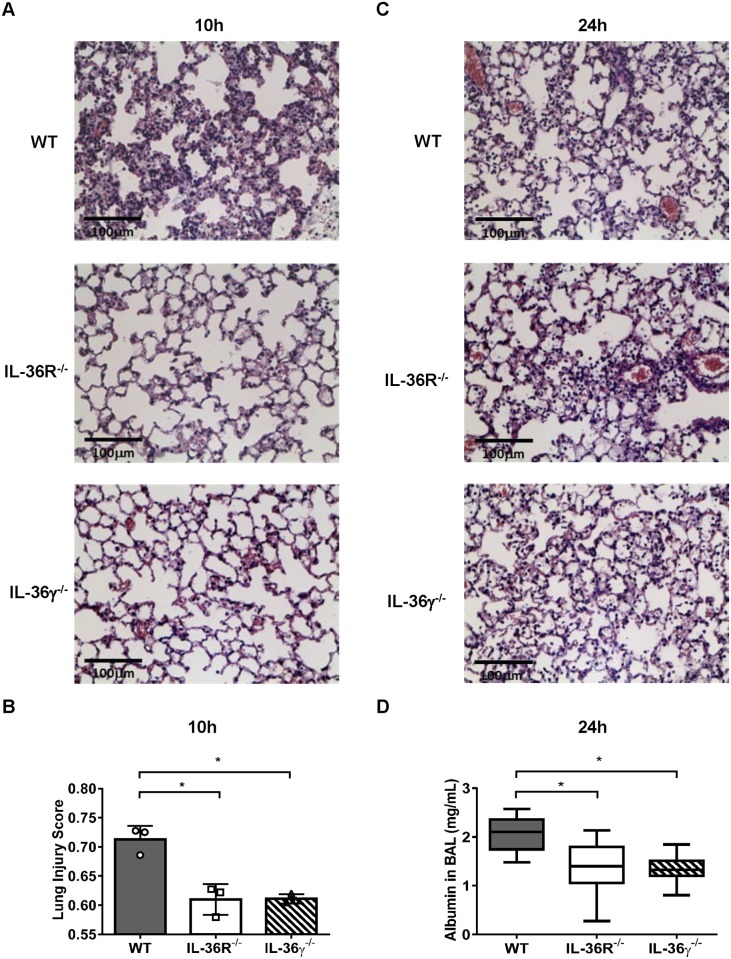
IL-36 receptor and IL-36γ deficient mice attenuated lung injury during P. aeruginosa infection.(A, C) Lung histopathological analysis in P. aeruginosa infected WT, IL-36R-/- and IL-36γ-/- mice was performed at 10 h (A) and 24 h (C) post infection. H&E-stained lung tissue at magnification of 400X. (B) The quantification of lung injury in lung sections with infected-WT, IL-36R-/- and IL-36γ-/- mice at 10 h were evaluated as previously described (n = 3 per each group). Lung injury scoring system parameters include neutrophils in the alveolar space (i), neutrophils in the interstitial space (ii), hyaline membranes (iii), proteinaceous debris filling the airspaces (iv) and alveolar septal thickening (v). At least 20 random regions were scored 0–2 independently and the final lung injury score was calculated as below; score = [(20 × i) + (14 × ii) + (7 × iii) + (7 × iv) + (2 × v)] / (number of fields × 100). (D) Lung permeability was quantified by albumin concentration in BAL fluid from 6 h and 24 h post infection (n = 6–8 per each group). All data are shown as means ± SD. * p<0.05, compared with WT mice.